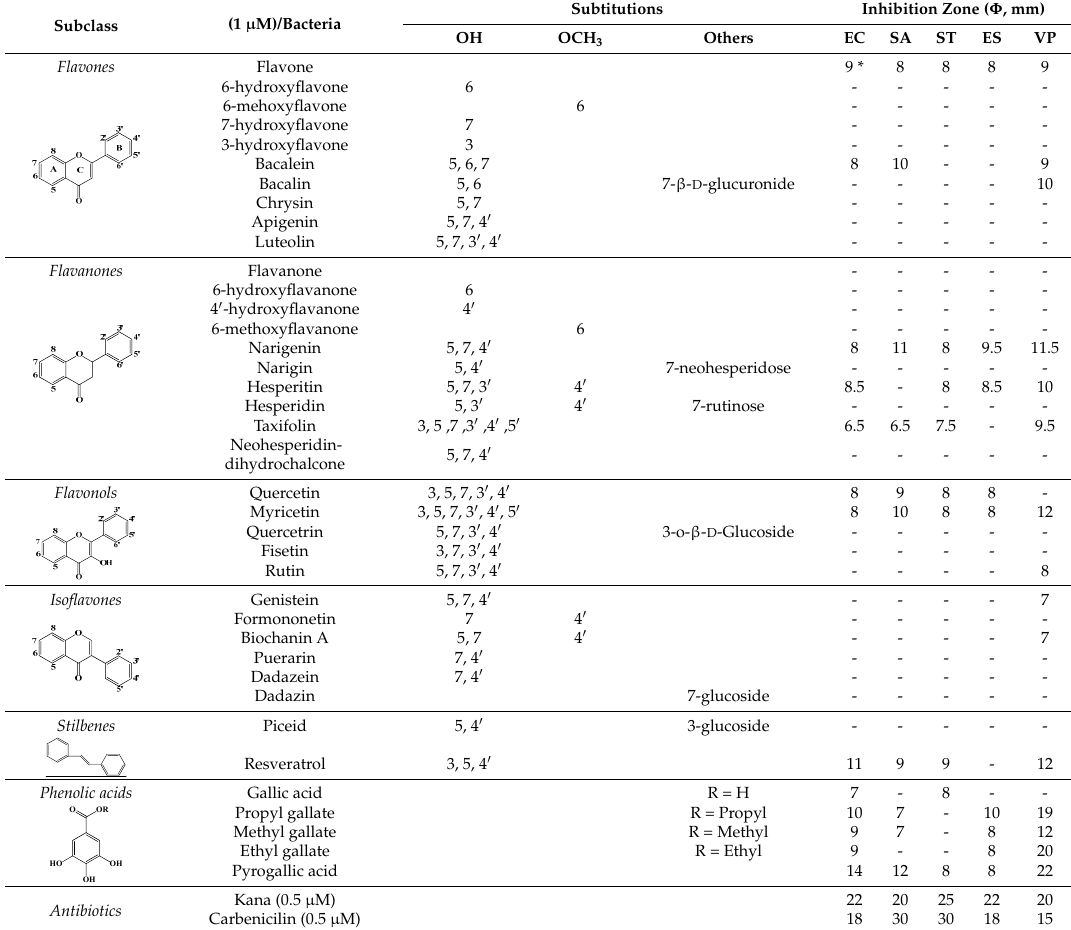
Table 2. Results of antimicrobial susceptibility tests for polyphenols.